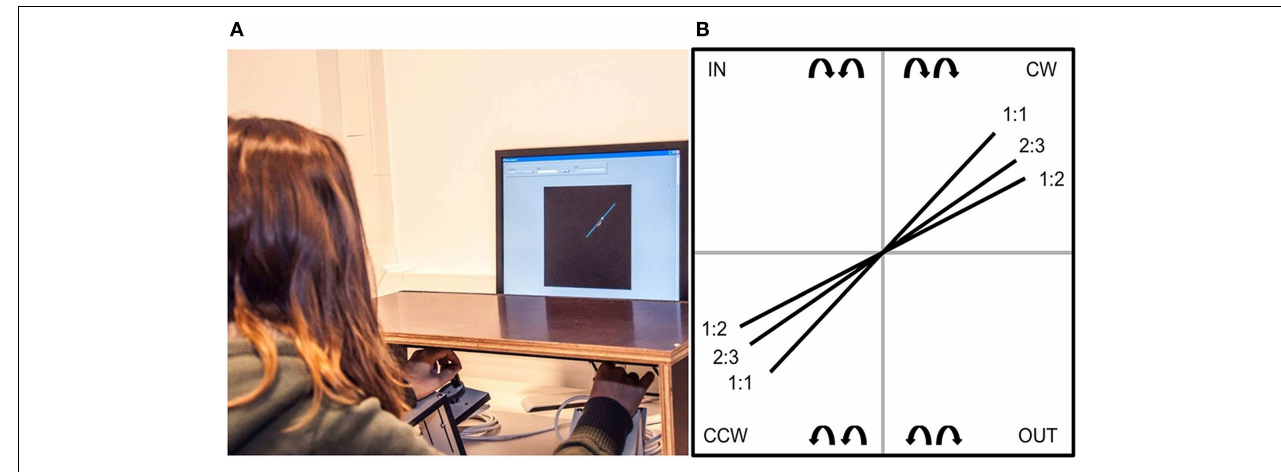
shown on the screen, from which subjects could deduct the three frequency ratios (1:1, 2:3, and 1:2) and coordination directions [clockwise (CW) and counterclockwise (CCW)]. The coordination directions inwards (IN) and outwards (OUT) are shown here, but were not part of the training protocol (Pauwels et al.,